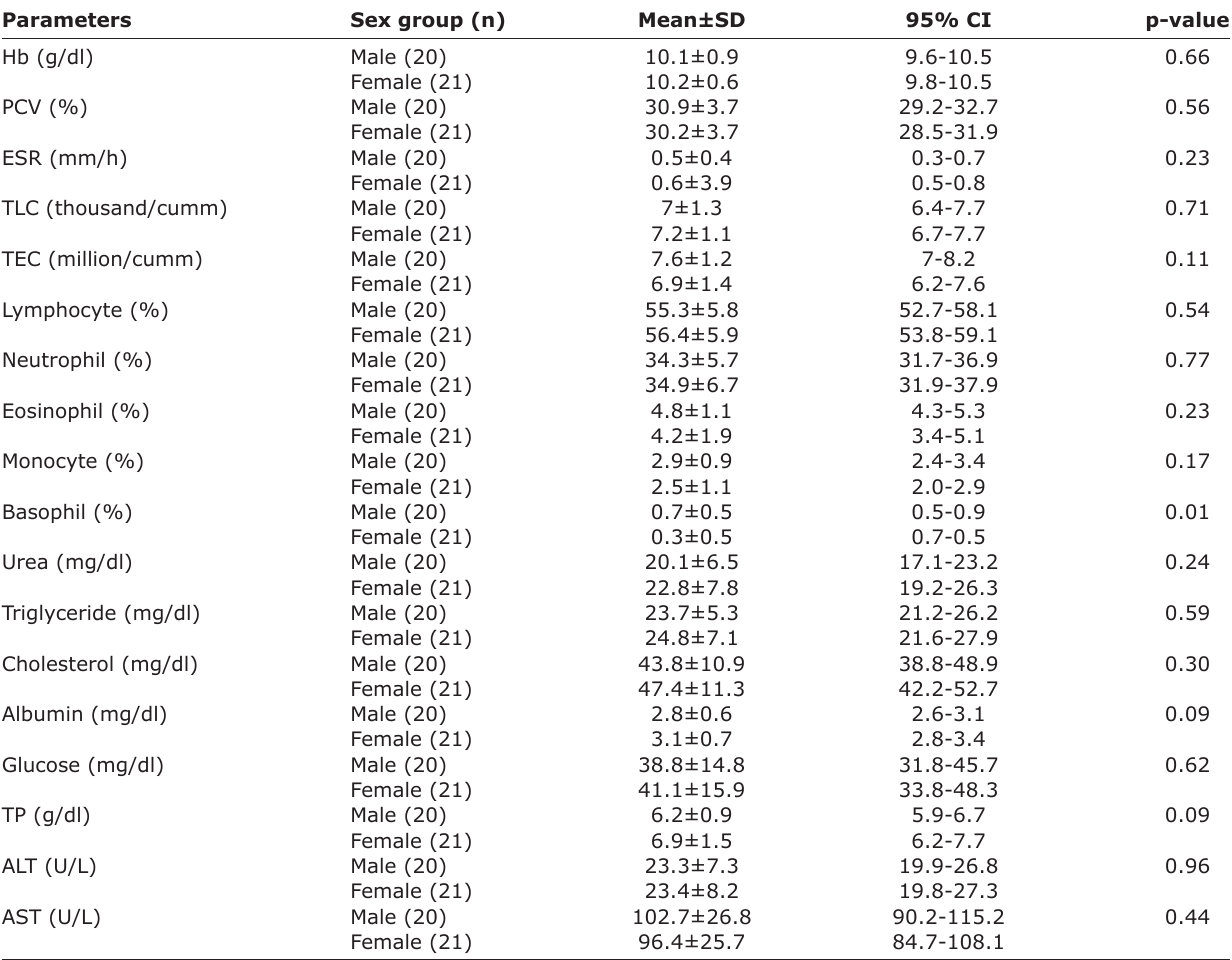
Table-3: Comparison of biochemistry and hematology profiles between healthy male and female indigenous sheep (O. aries) of Bangladesh.